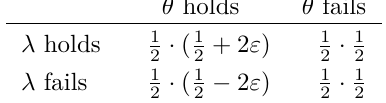
Table 22: An Example of a Dependent Distribution θ